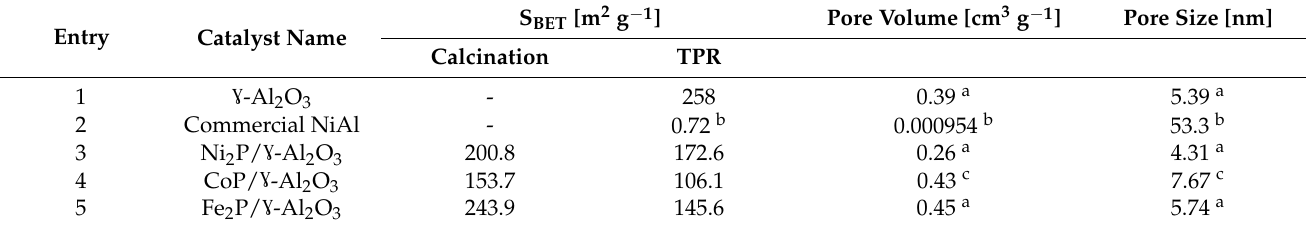
Table 2. BET (Brunauer-Emmett-Teller) properties of the support and catalysts ( b [46], a [47], c [48]).